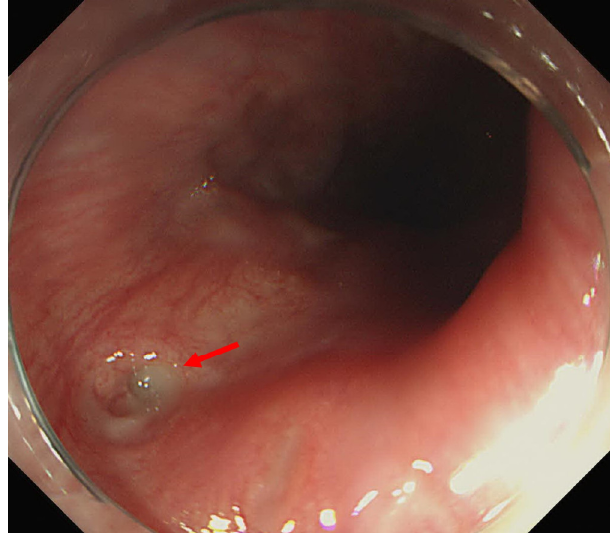
Figure 6. A 76-year-old woman with acute phlegmonous esophagitis. Endoscopy shows normal esophageal mucosa and a small opening (arrow) at the upper esophagus.